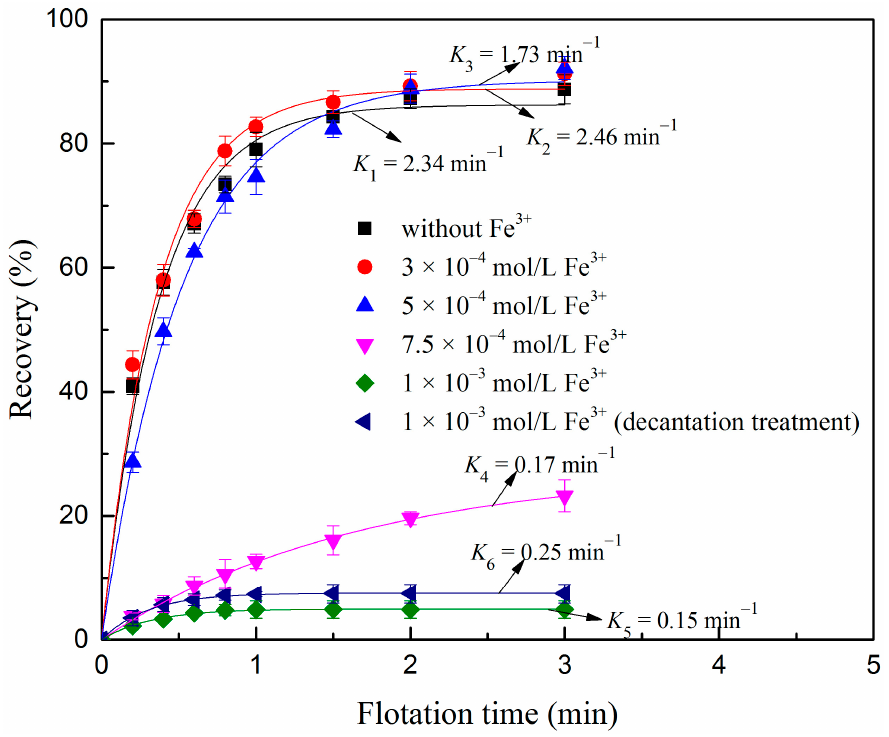
Figure 3. Flotation recovery of digenite as a function of flotation time with respect to Fe 3+ dosage (pH: 7.0; Na 2 S dosage: 1.25 × 10 − 3 mol/L; SBX dosage: 1 × 10 − 4 mol/L).